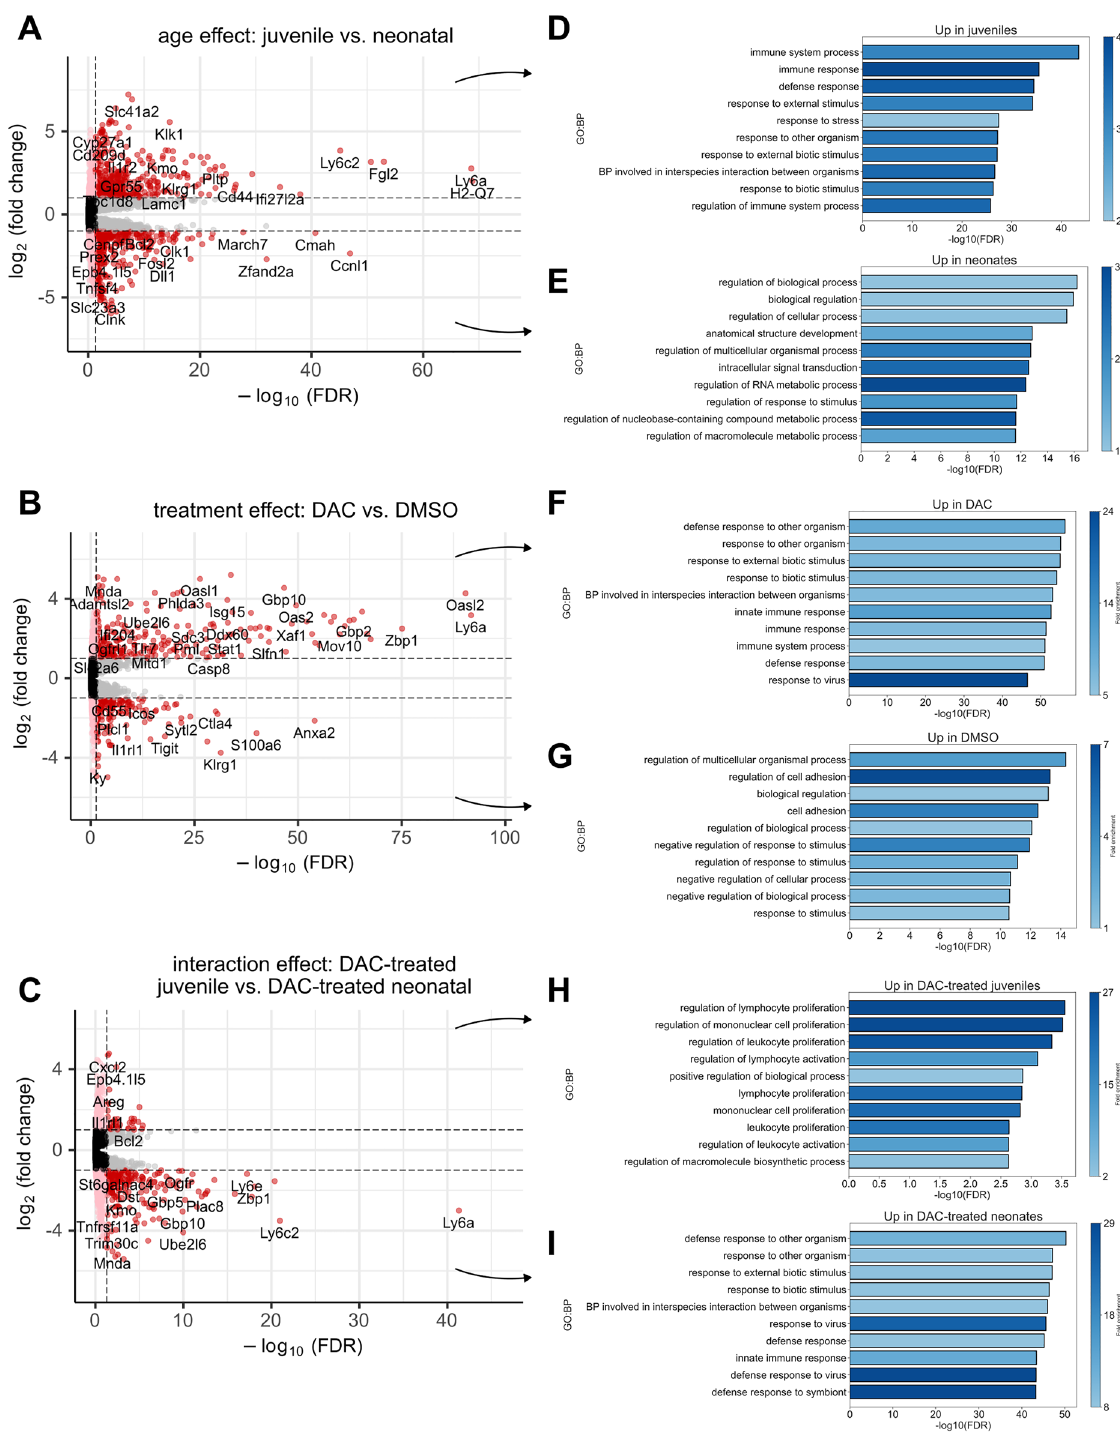
Figure 3. Age and DAC treatment independently and in concert induce gene expression changes in immune program genes. ( A ) Volcano plot showing the log 2 -fold changes (LFCs) in gene expression as a function of age (juvenile versus neonatal). Genes with positive LFC values are expressed at higher levels in juveniles than neonates. ( B ) As in ( A ) for the DAC versus DMSO comparison after regressing out the effect of age. ( C ) As in ( A , B ) for the interaction between age and treatment status. ( D ) Over-representation analysis (ORA) from gProfiler showing GO: Biological Processes (GO:BP) associated with genes up-regulated in juveniles versus neonates, and ( E ) neonates versus juveniles. Fold-enrichment (colorbar) in this context is the number of genes associated with a term divided by the number of genes expected to be associated with that term by random chance. ( F ) as in ( D ) for genes up-regulated CD4 + T cells from DAC-treated mice versus DMSO, and ( G ) for DMSO-treated mice versus DAC. ( H ) as in ( D ) for genes more greatly increased in expression in DAC-treated juveniles than neonates. ( I ) as in ( E ) for genes more greatly increased in expression in DAC-treated neonates than